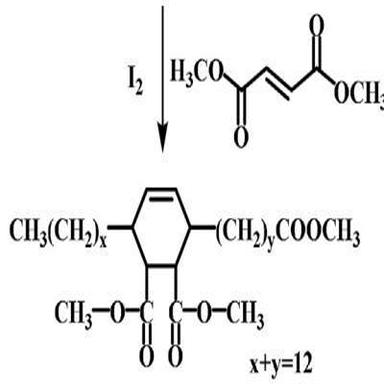
Synthesis route of C22TAE. C22TAE, 22-carbon tricarboxylic ester.